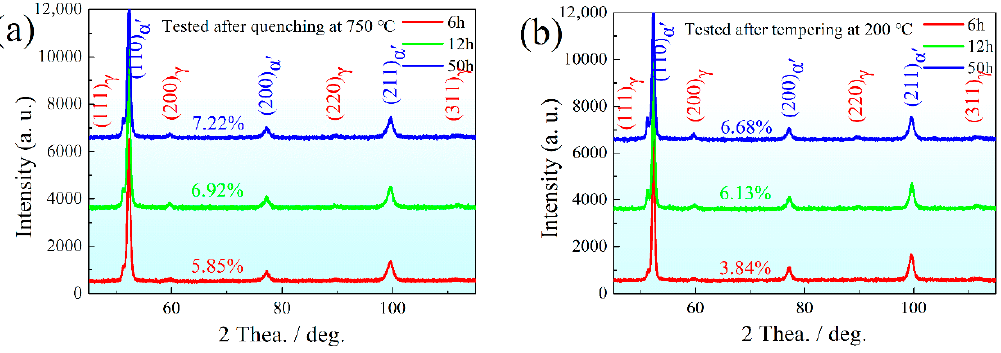
Figure 7. XRD line spectra: ( a ) quenching at 750 °C; ( b ) tempering at 200 °C.